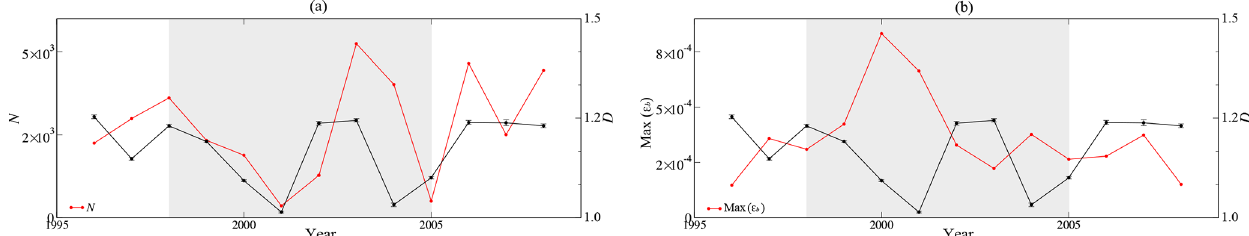
Figure 5. Box-counting dimension of µ(t) for the solar wind with j = 100 (black line), and the activity of the dissipated magnetic energy (cid:15) b (t) (red line), as measured by the parameter N (a) and max ((cid:15) b ) (b) . Threshold to define activity is n = 5 (see Eq. 8). The grey region corresponds to years of maximum solar activity, as described in the text.